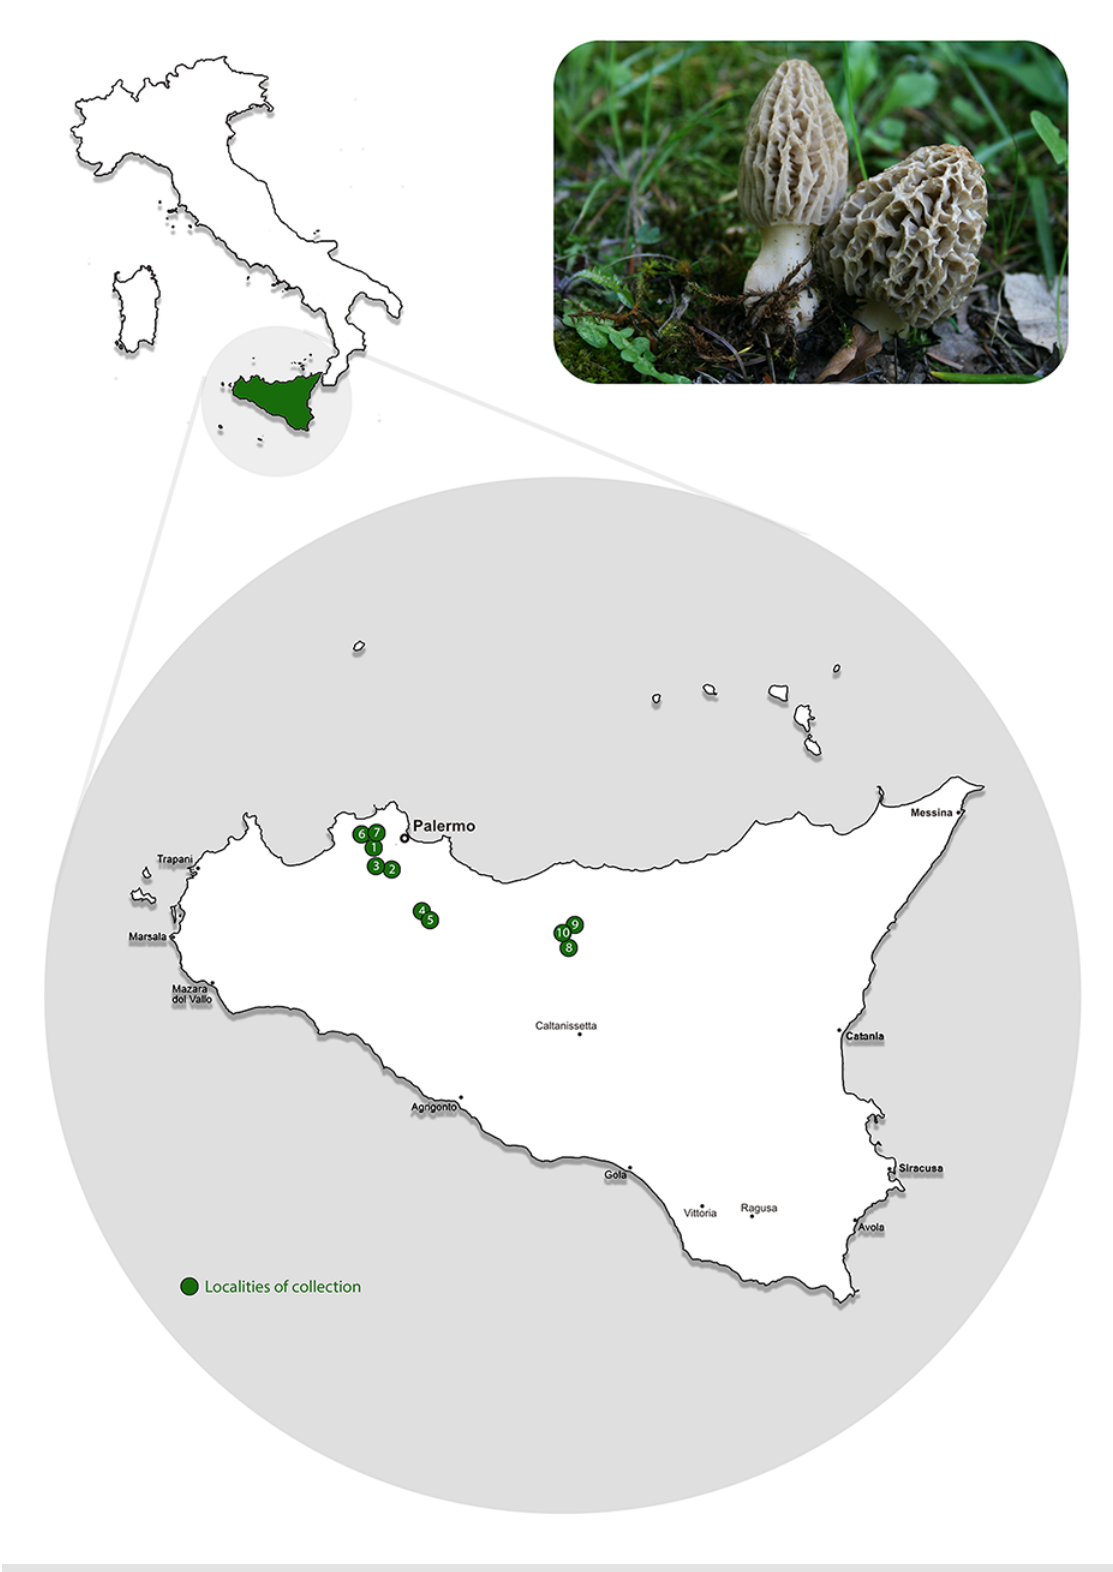
Fig. 1 Map of the study sites and the picture of M. esculenta